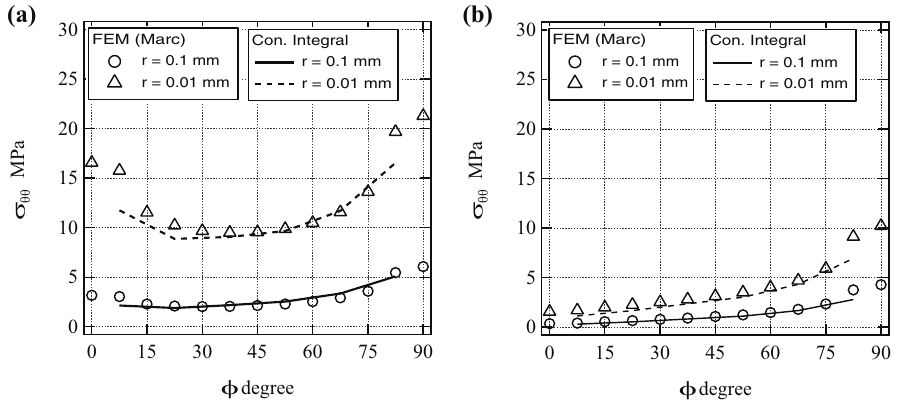
Figure 7: Distribution of normal stresses, σ θθ , at the interface, = θ 90° , with fi xed r at 0.01 and 0.1 mm: ( a ) Vertex - 1 and ( b ) Vertex - 2.